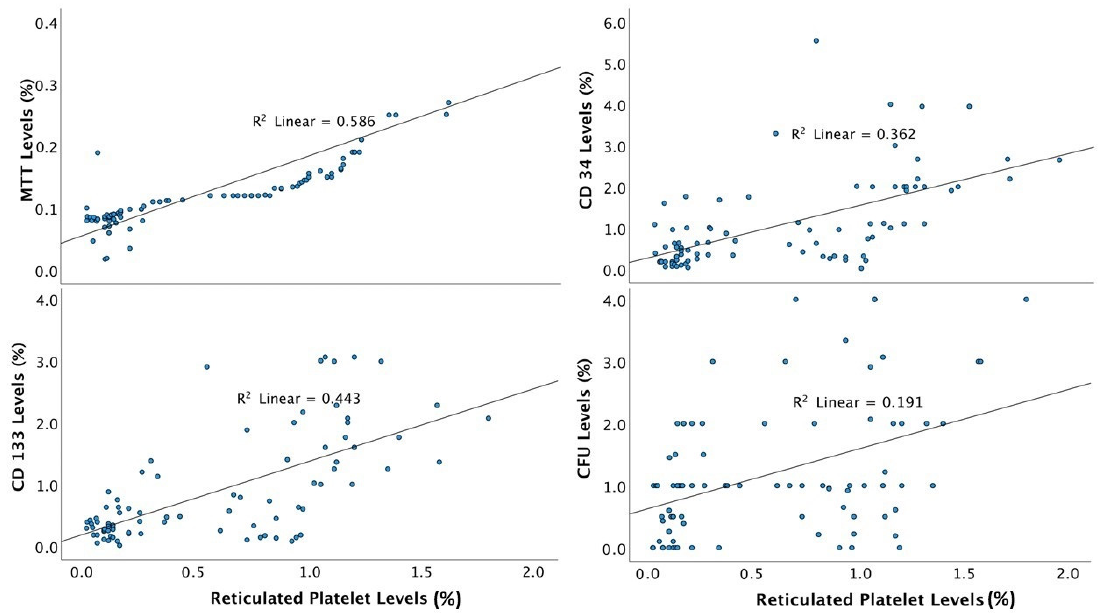
Figure 2. Regression analysis of EPC markers by RP tertiles at baseline assessment. CFU = colony- forming units; MTT = 3-(4,5-dimethylthiazol-2-yl)-2,5-diphenyl tetrazolium